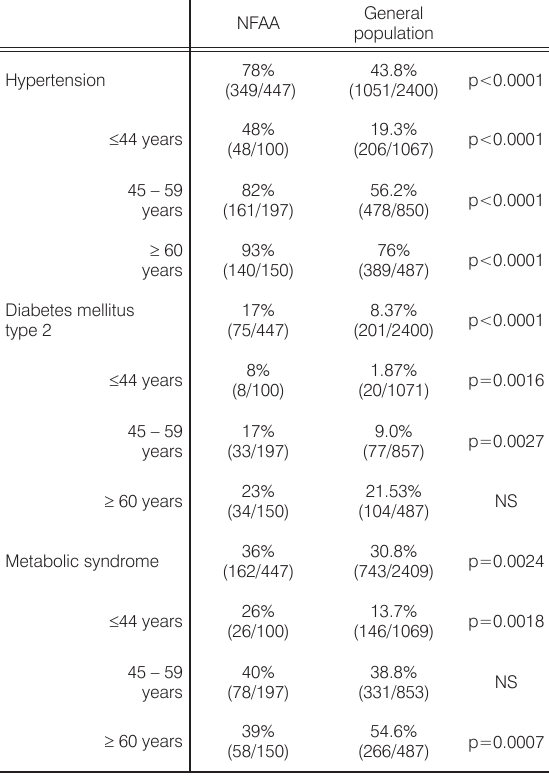
Table 2. Prevalence rates of arterial hypertension and metabolic disorders in patients with non-functioning adrenal adenomas (NFAA) and subclinical Cushing's syndrome.